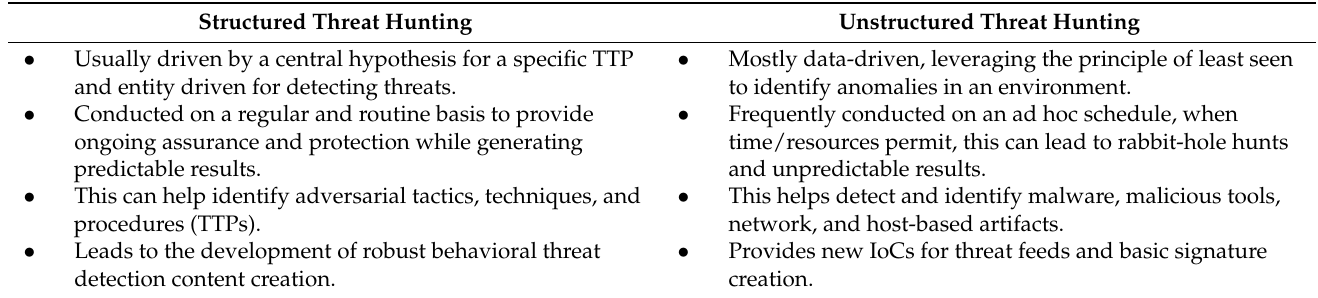
Table 1. Structured vs. unstructured threat